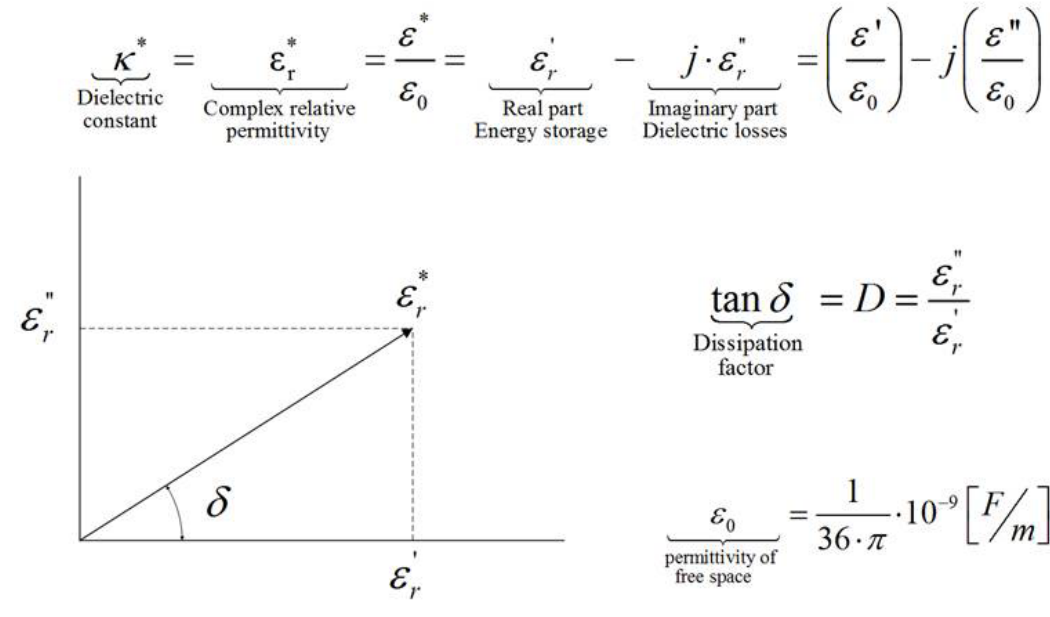
Figure 1. Definition of complex relative permittivity [26].